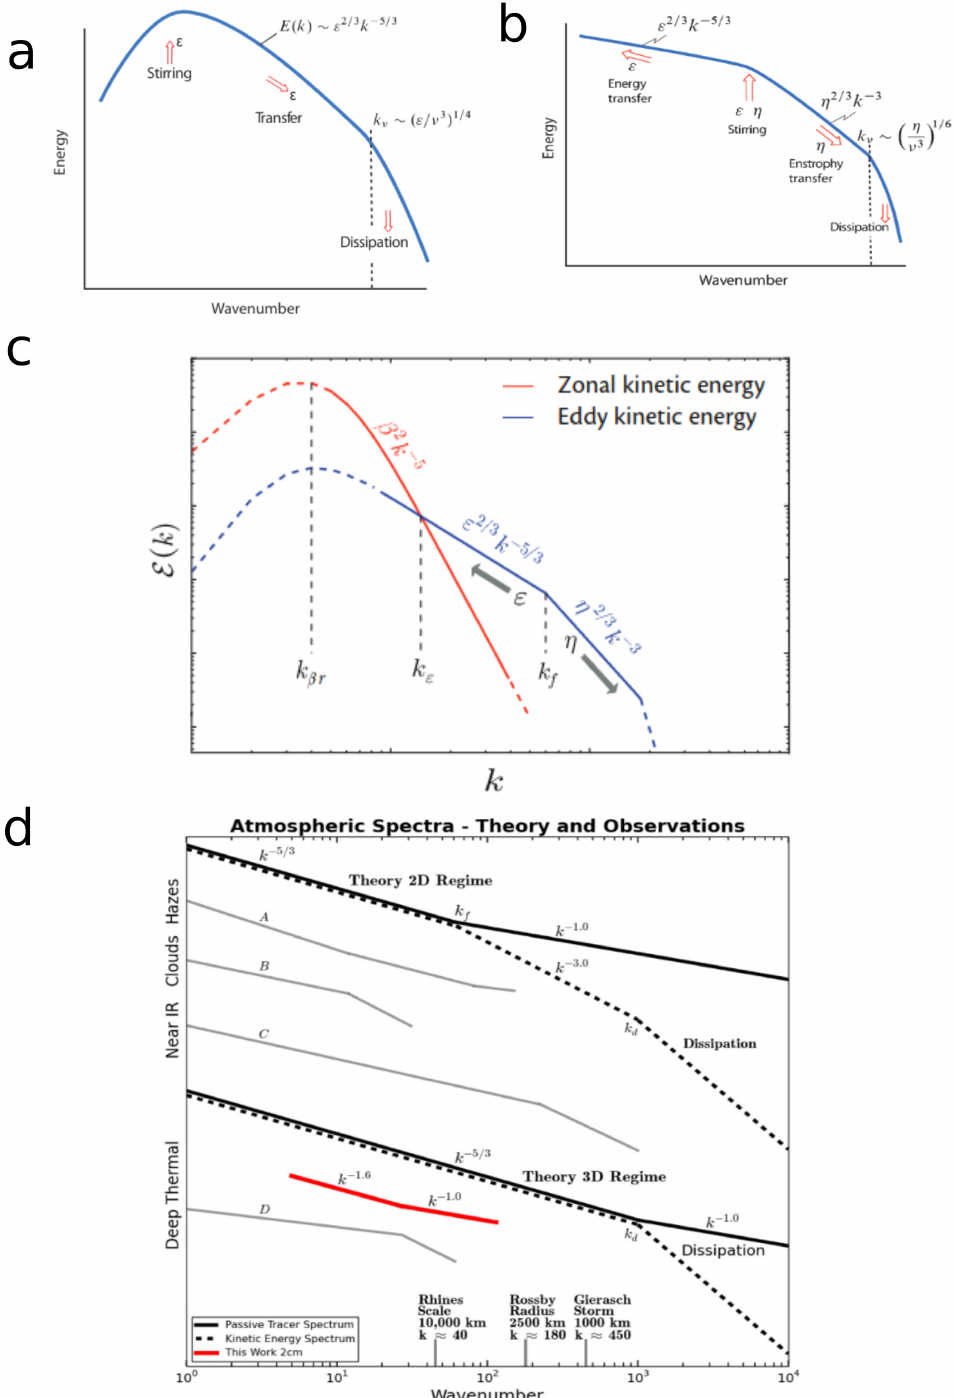
Figure 12. Idealized Turbulent Energy Power and Passive Tracer Power Spectra. ( a ) Idealized 3D Turbulent Energy, ( b ) Idealized 2D Turbulent Energy, ( c ) Idealized Geostrophic Energy. ( d ) Turbulent Energy vs. Passive Tracer Spectra. ( a – c ) Reproduced from [137] ( d ). Select Jupiter spectra reproduced from [160]. Thin black lines labeled A–D and the thick red line are for individual observations detailed in